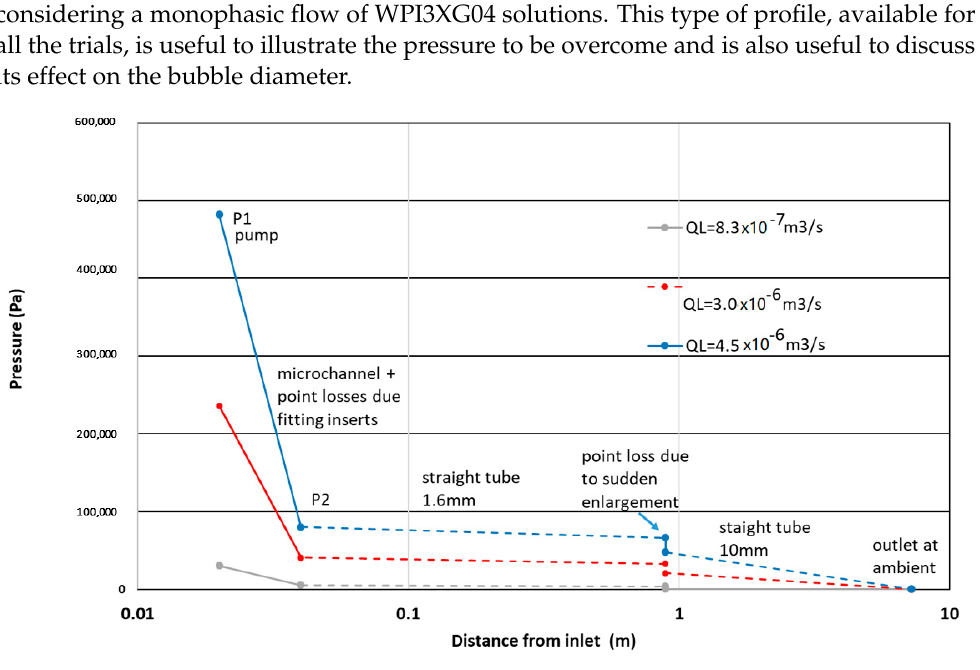
Figure 3. Example of the profile of the relative pressure along the microchannel hydraulic loop for the WPI3XG04 solution and three different flowrates. The log scale presentation of the axial coordinate aims to show more clearly the important weight of the microchannel in the global pressure drop. The downstream pressure drop is shown as a dotted line, and it concerns the successive tubes of the relaxation line and is roughly